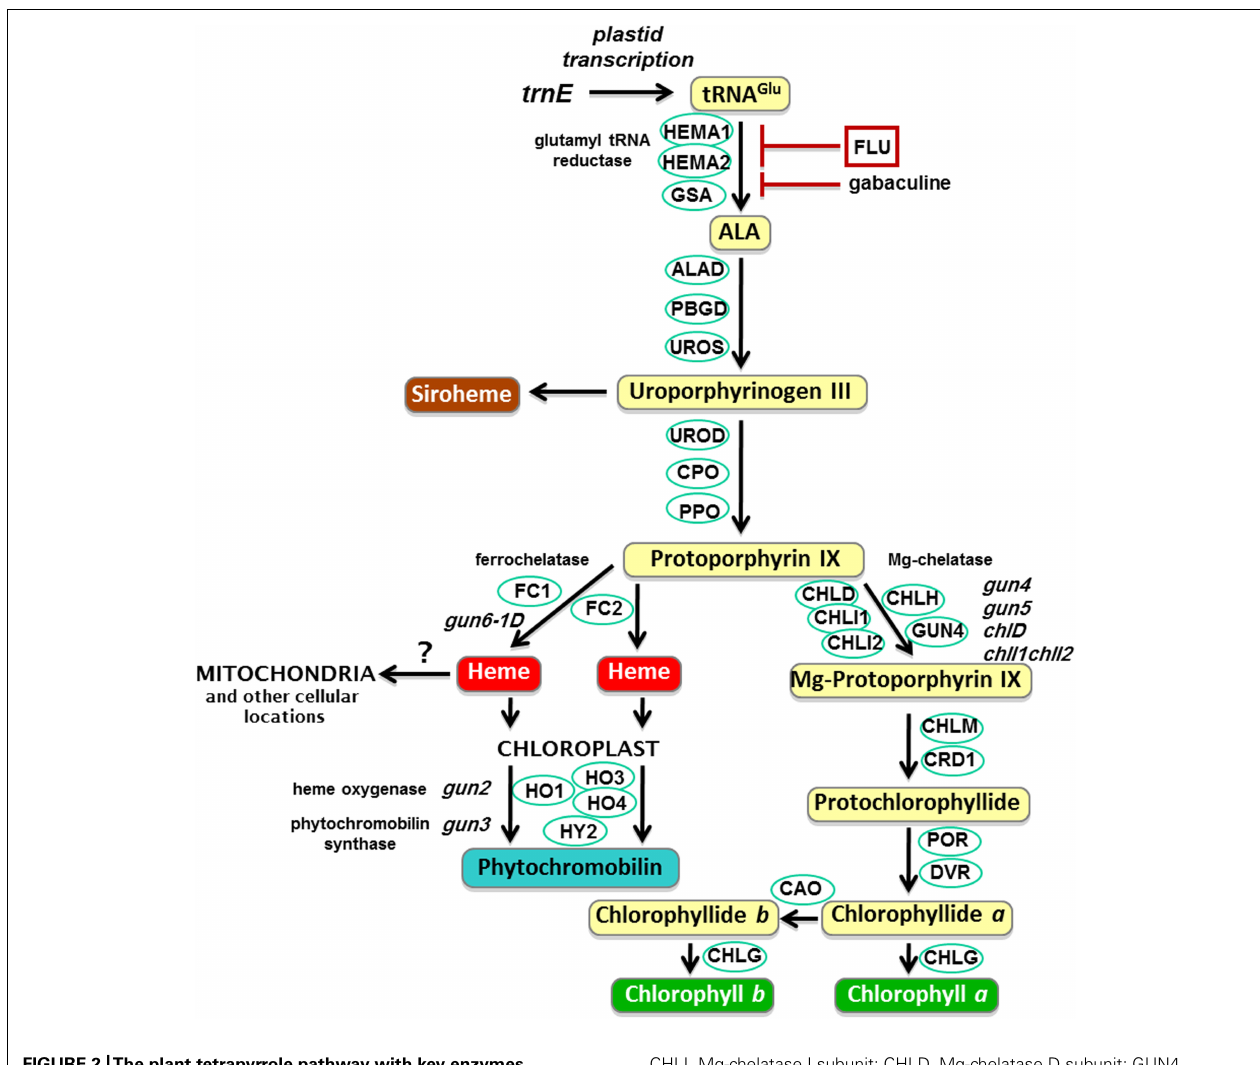
FIGURE 2 |The plant tetrapyrrole pathway with key enzymes and gun mutants. ALA, 5-aminolevulinic acid; HEMA, glutamyl-tRNA reductase; GSA, glutamate-1-semialdehyde 2,1-aminomutase; ALAD, 5-aminolevulinate dehydratase; PBGD, porphobilinogen deaminase; UROS, uroporphyrinogen III synthase; UROD, uroporphyrinogen III decarboxylase; CPO, coproporphyrinogen III oxidase; PPO, protoporphyrinogen IX oxidase; CHLH, Mg-chelatase H subunit;